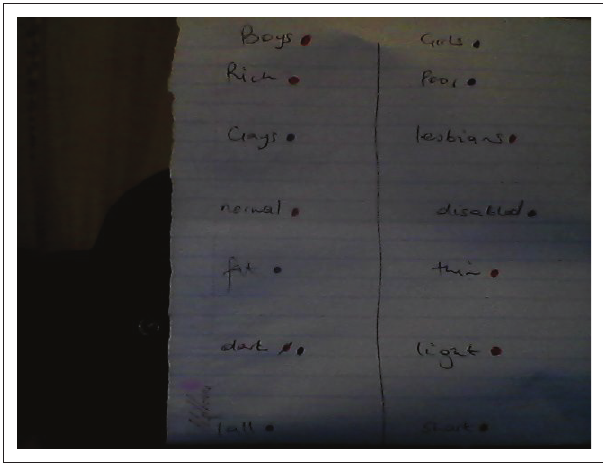
FIGURE 1: The red dots depict social identities which the participants regarded as dominant and thus perpetrators of bullying. Likewise, the blue dots show subservient social identities, which predisposed learners to be victims of